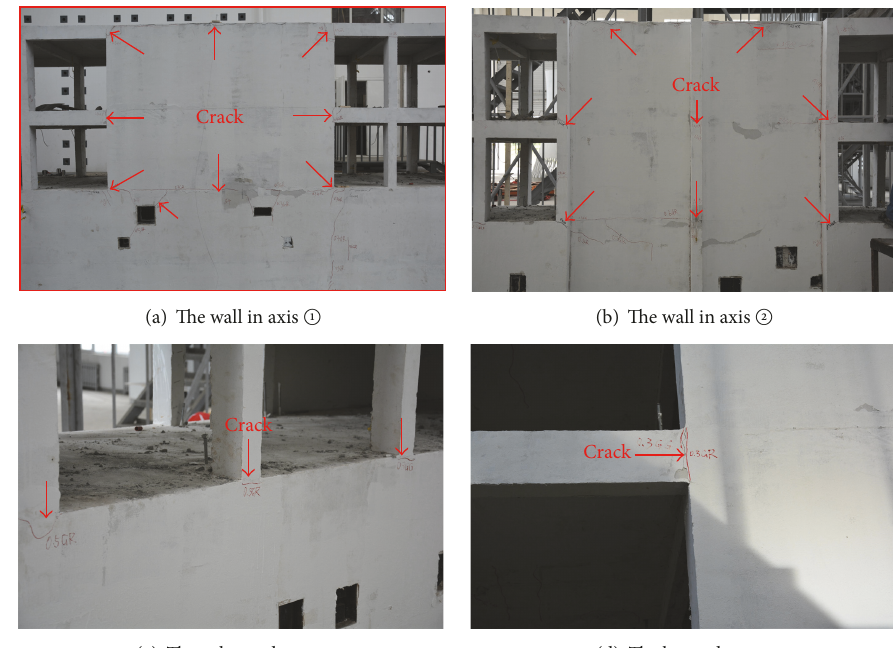
Figure 11: Seismic damage to test